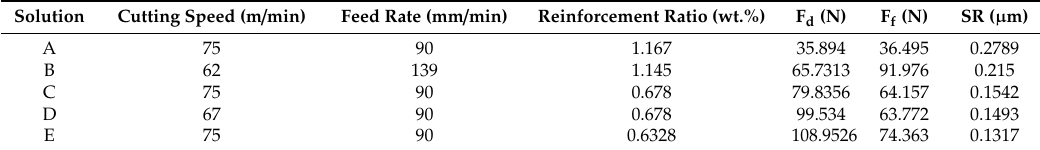
Figure 9. Optimal solution ( a ) 3D Pareto front solution set for objective functions (F d , F f , and SR); ( b ) 2D Pareto front graph for objective functions (F d and SR). Table 11. Optimal milling parameter and reinforcement ratio